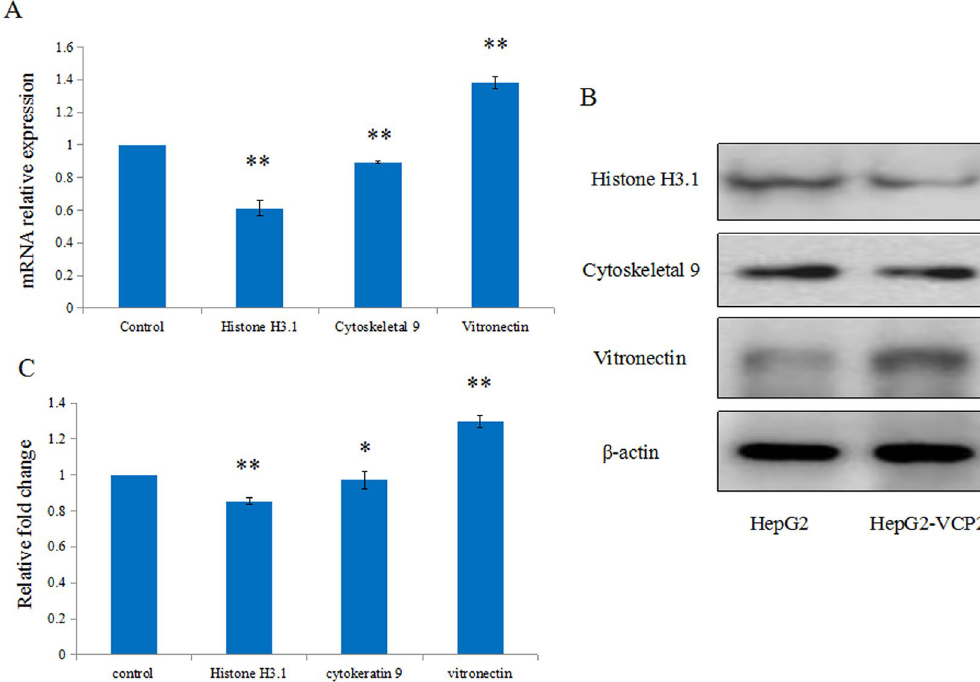
Figure 3. Validation by qRT-PCR and WB. ( A ) Validation of mRNA level in normal and polysaccharides- treated HepG2 cells by qRT-PCR assay. ( B ) Validation of the protein level in normal and polysaccharides- treated HepG2 cells by WB assay. ( C ) Graphical representation of the average fold change in expression of the proteins between HepG2 cells and polysaccharides-treated HepG2 cells. Gene expression is normalized to β -actin expression. Values are means ± SD (n = 3), * p < 0.05, ** p < 0.01. The full-length gels and blots are included in Supplemental Fig.